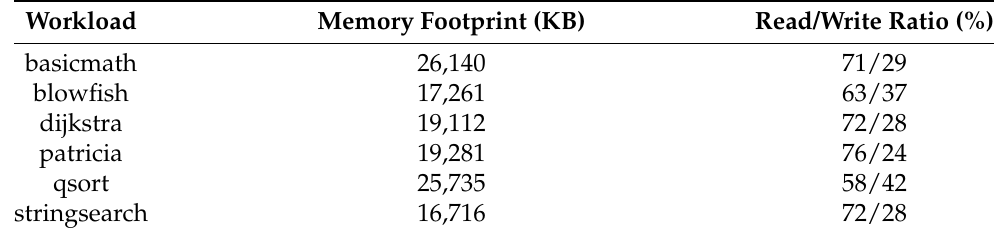
Table 6. Workload